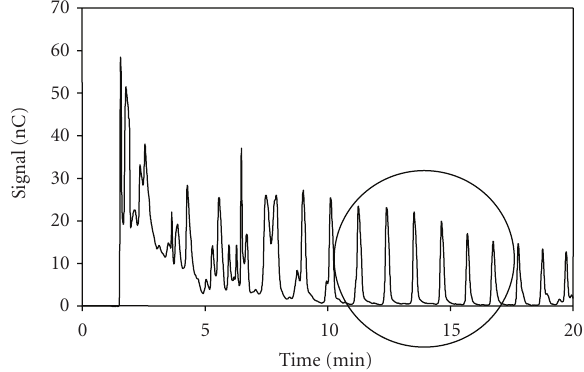
Figure 7: Chromatographic profile of an extract of inulin from a cooked ham sample, showing inside the circle the oligosaccharide fraction selected to perform quantitative evaluation of inulin present in the analyzed sample. Chromatographic conditions as in the